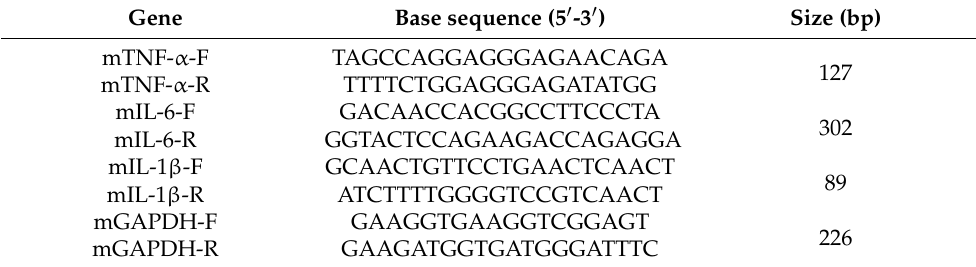
Table 1. Primer sequences for